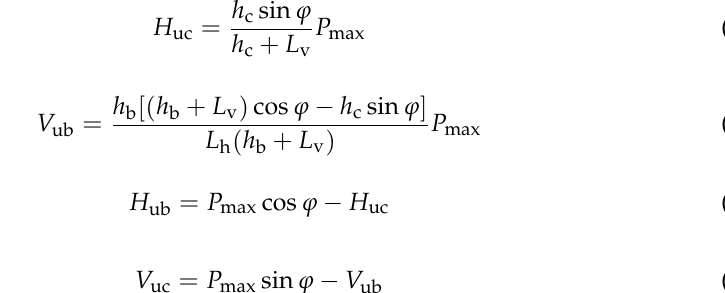
Figure 3. According to the force equilibrium requirement for the gusset plate, the gusset- to-column and gusset-to-beam interface forces can be obtained as follows: